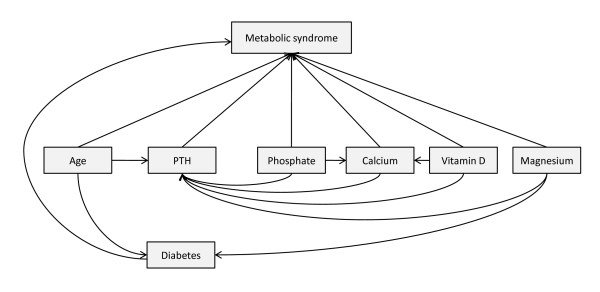
Path diagram showing hypothesized relationships between variables, decomposed into direct and indirect effects. Path diagram showing hypothesized relationships between variables as suggested in the literature, decomposed into direct and indirect effects. The indirect pathways between the included explanatory variables and MS were hypothesized to be mediated by PTH. Arrows represent dependencies between variables. Absence of an arrow between two variables indicates that the variables are considered to be statistically independent in the model.